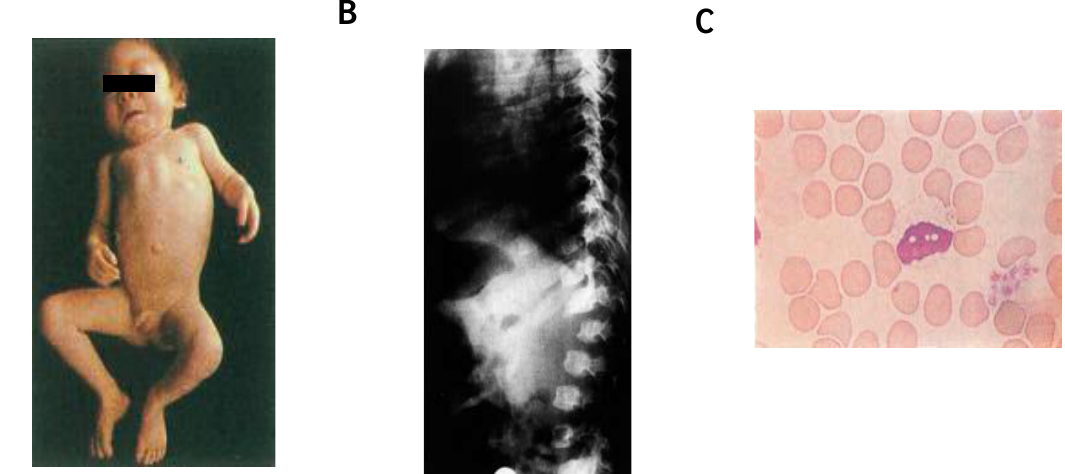
Figure 1. Clinical feature of I-cell disease (kindly provided by Dr. Tadao Orii). We have signed the inform consent ( A ). A full-body image of the patient with I-Cell disease (a 13-month-old boy). The patient has a distinct coarse face, short neck, umbilical hernia, thick skin, and rigidity of joints. ( B ). The vertebral side image of a patient with I-cell disease (a 9-month-old boy). Anteroposterior diameter of the vertebral body and ossification of the anterior upper border of the lumbar vertebral body are reduced. Dysfunction is observed and hump-back of the vertebral L2 body. ( C ). Peripheral blood lymphocytes (at 40× magnification) of I-cell disease (mucolipidosis II) (May - Giemsa staining). The cytoplasm is filled with numerous vacuoles.